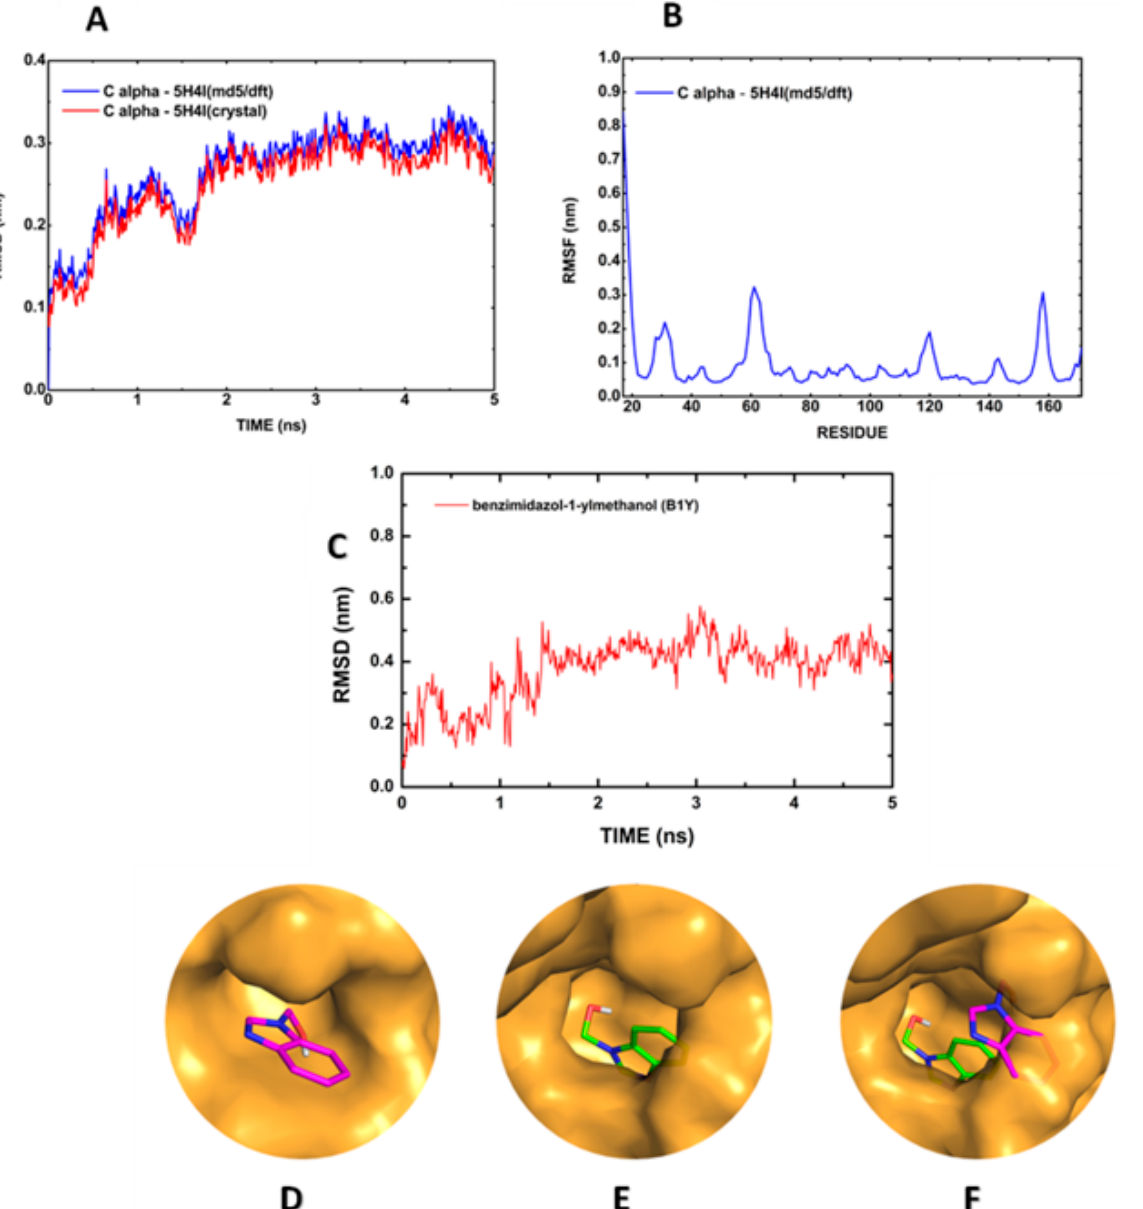
Figure 4. Molecular dynamics simulation of the B1Y:5H4I structure in water: ( A ) C α RMSD; ( B ) C α RMSF; ( C ) RMSD of B1Y relative to the protease; ( D ) B1Y position in the co-crystallized structure; ( E ) B1Y at 3 ns of the MD; ( F ) superposition of the co-crystallized B1Y position, and the MD final position.